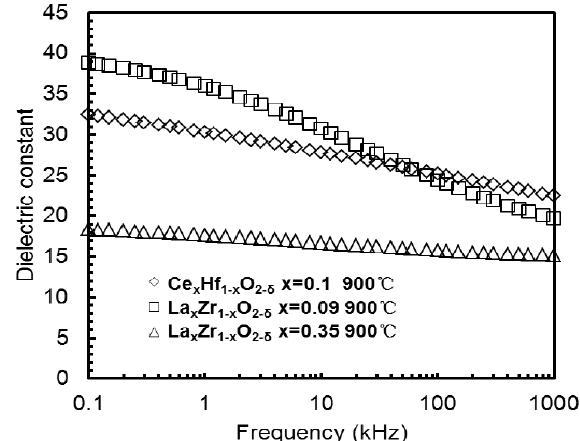
Figure 15. Frequency dependence of the k -value was extracted from C- f measurements of Zr O and La Zr O thin films annealed at 900 °C, or extracted from La 0.35 0.65 2 −δ 0.09 0.91 2 −δ Figure 13 (a,b). Frequency dependence of the Ce Hf O thin film was extracted from x 1 − x 2 −δ Figure 5